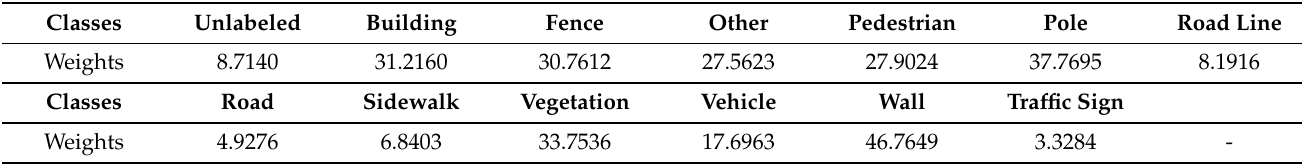
Table 1. Our Carla 13 classes with their